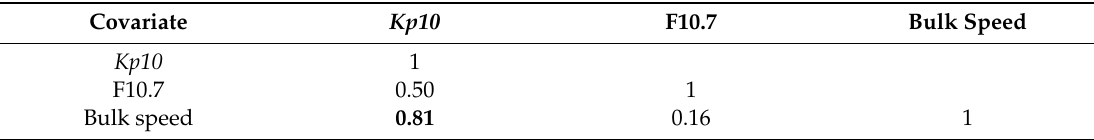
Table 2. Correlation coe ffi cients for geomagnetic field and space-related variables during the study period. Covariate Kp10 F10.7 Bulk Speed Kp10 1 F10.7 0.50 1 0.81 0.16